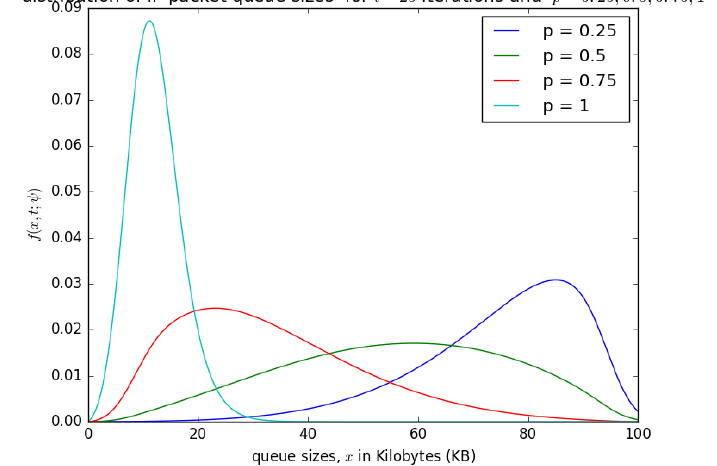
Figure 18. The distribution of the aggregation queue size, f ( x , t ; ψ ) for the i = 25 iterations and different values p